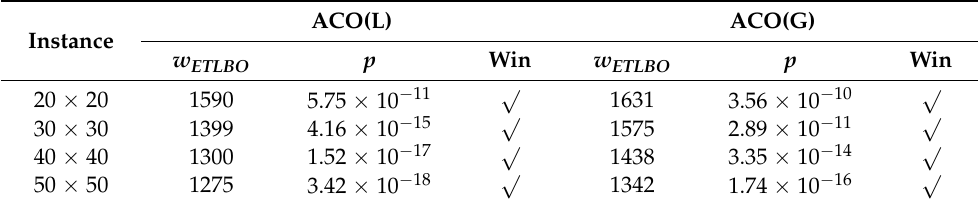
Table 7. Wilcoxon rank-sum test for MRPP